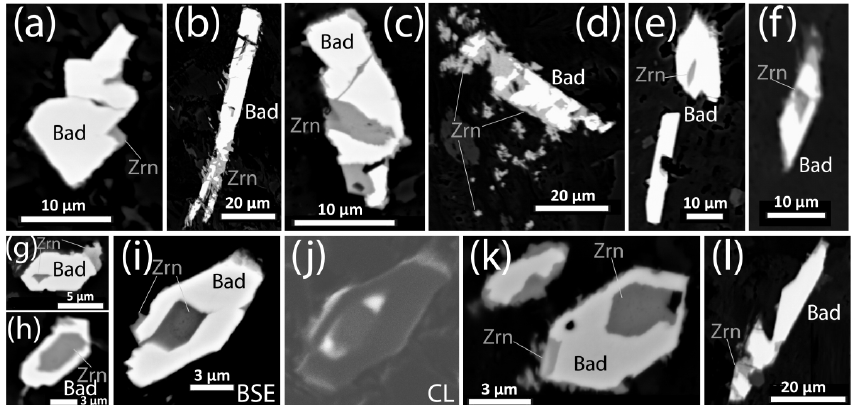
Figure 4. BSE and cathodoluminescence (CL; j ) images of baddeleyite–zircon intergrowths in SEIC sample FP12A. (a–d) Baddeleyite of different habits, intergrown with variable proportions of zircon. (e–l) Baddeleyite with zircon inclusions and notches.